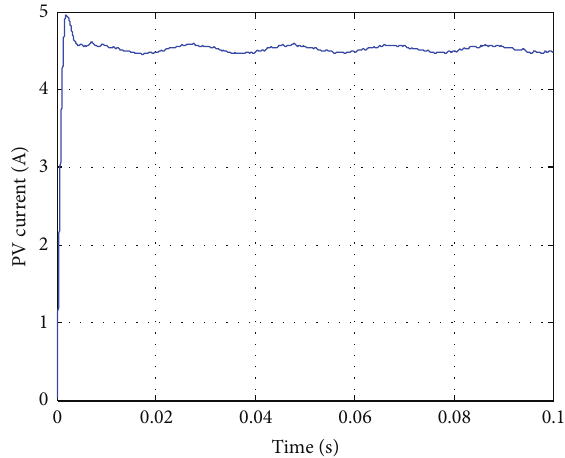
Figure 15: Variation of PV array voltage in time domain.